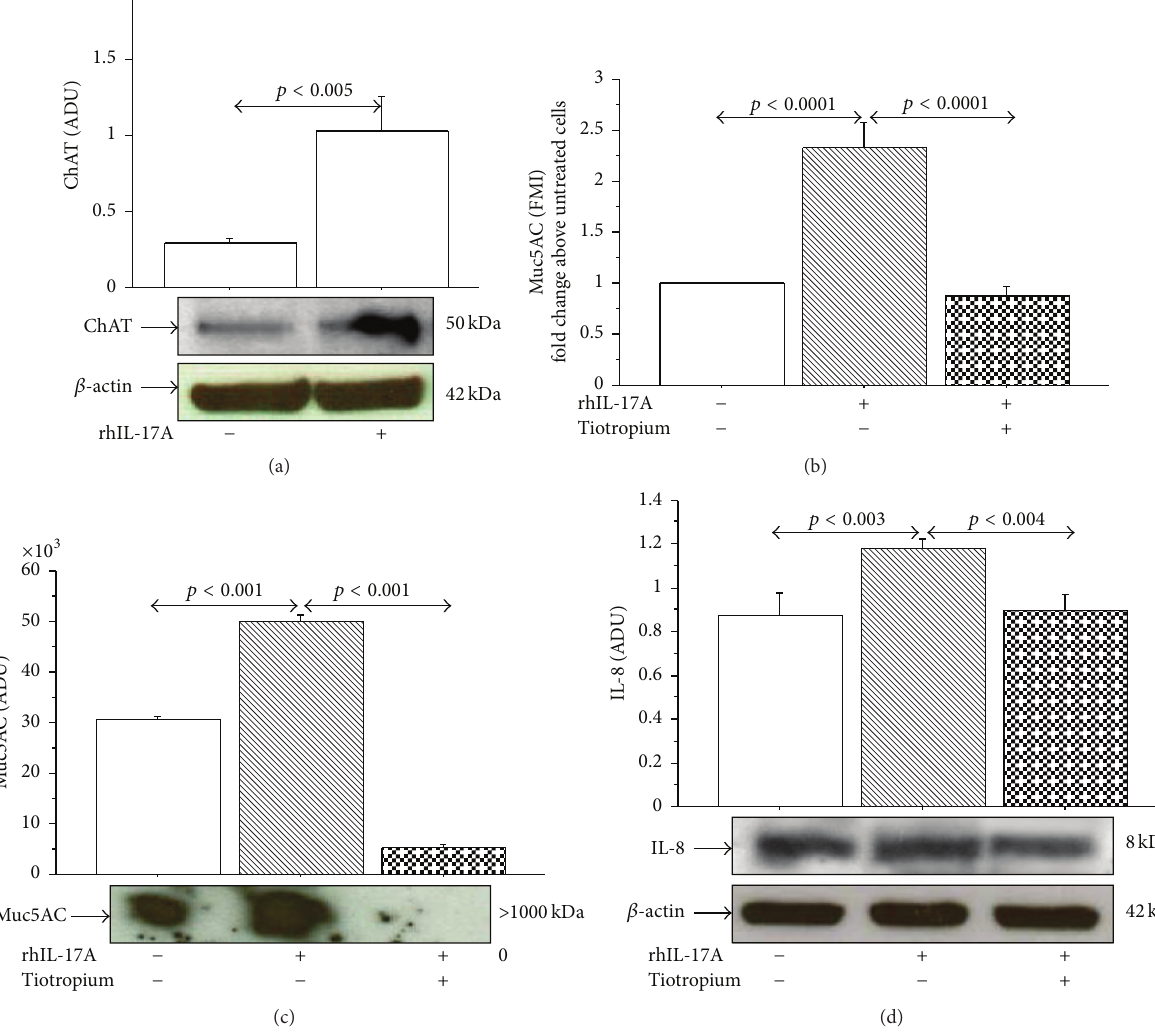
Figure 9: Effect of Tiotropium on ChAT, Muc5AC, and IL-8 in N-HBE cells. Cells were incubated for 1h with Tiotropium (100nM) before addition of rhIL-17A 20 ng/mL for 24h to evaluate (a) ChAT protein expression by western blot. Bars represent mean ± SD of arbitrary densitometric units (ADU). Representative western blot analysis of ChAT protein and 𝛽 -actin is shown. (b) Muc5AC protein expression by flow cytometry. Bars represent mean ± SD of fluorescence mean intensity (FMI) of three separate experiments and were plotted as fold change compared to untreated cells. (c) Muc5AC protein expression by western blot. Bars represent mean ± SD of arbitrary densitometric units (ADU) of three different experiments. Representative western blot analysis of Muc5AC protein is shown. (d) IL-8 expression by western blot. Bars represent mean ± SD of arbitrary densitometric units (ADU). Representative western blot analyses of IL-8 protein and 𝛽 -actin are shown. Statistical analysis was performed by ANOVA followed by Fisher’s PLSD multiple comparison test. 𝑝 < 0.05 was accepted as statistically